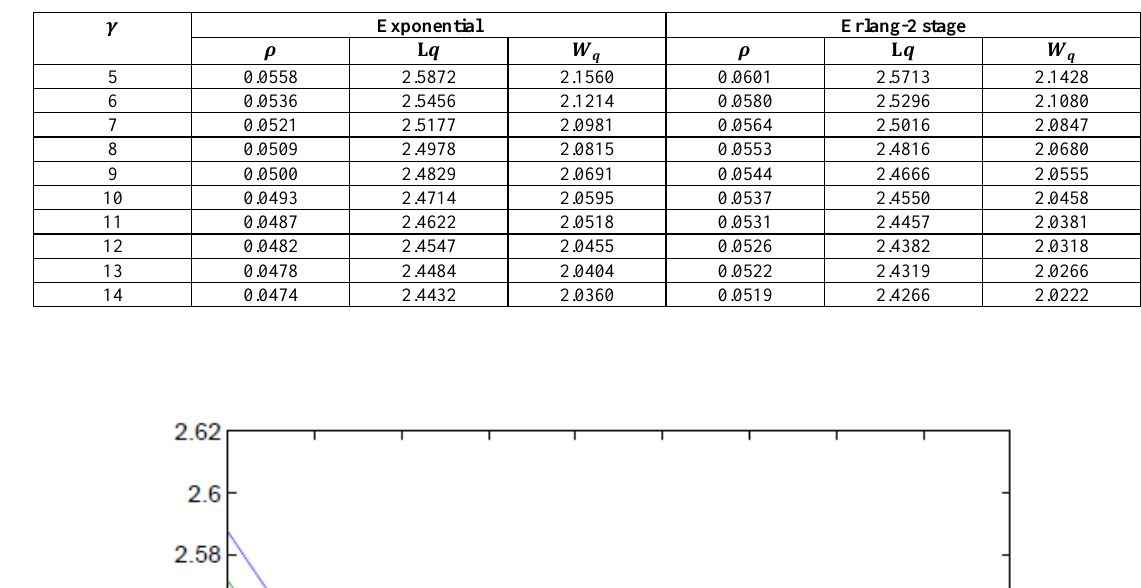
Table 4. The impact of the rate of vacation ( 𝛾 ) on 𝜌 , 𝐿